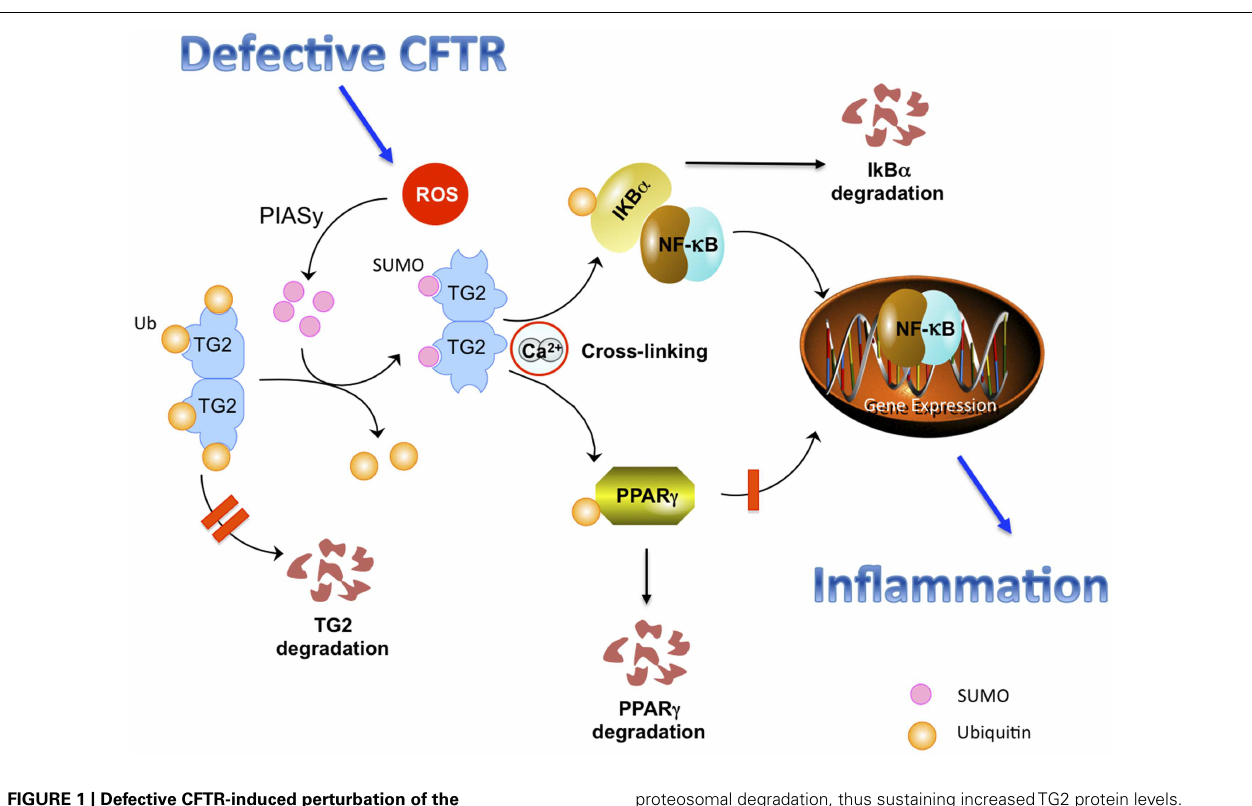
FIGURE 1 | Defective CFTR-induced perturbation of the post-translational network in CF epithelial cells. Defective CFTR leads to increased levels of reactive oxygen species (ROS) that increase the levels of the SUMO E3-ligase PIASy, causingTG2 SUMOylation, that, in turn, inhibitsTG2 ubiquitination, and avoids its